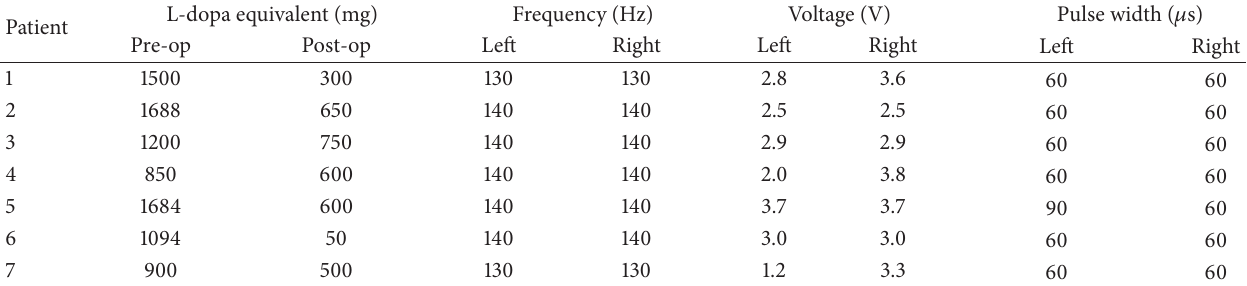
Table 1: Individual levodopa daily dose before and after surgery and DBS parameters at one-year followup.